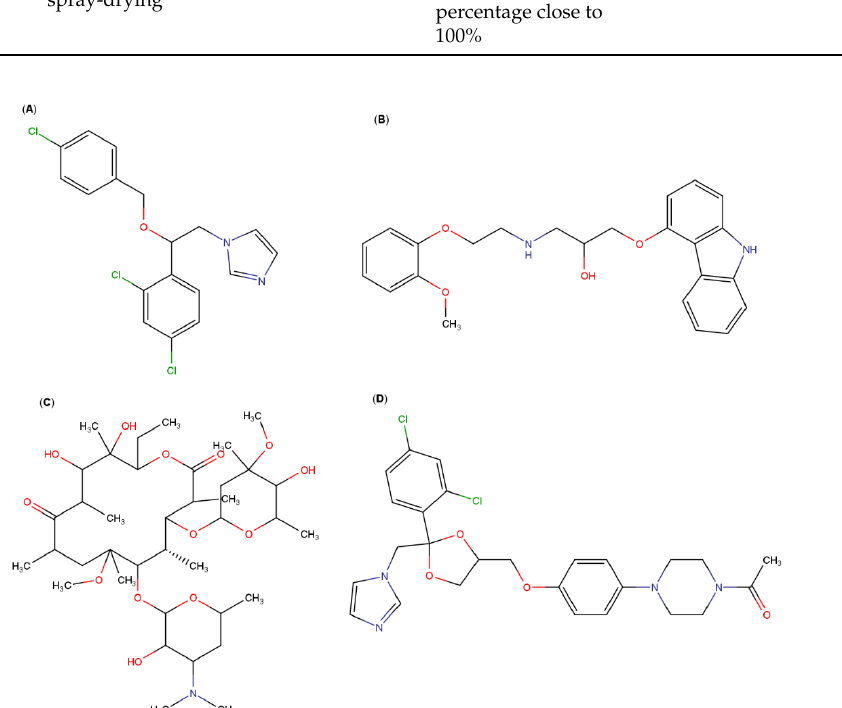
Figure 5. Molecular structures of: ( A ) econazole, ( B ) carvedilol, ( C ) clarithromycin and ( D ) ketoconazole.